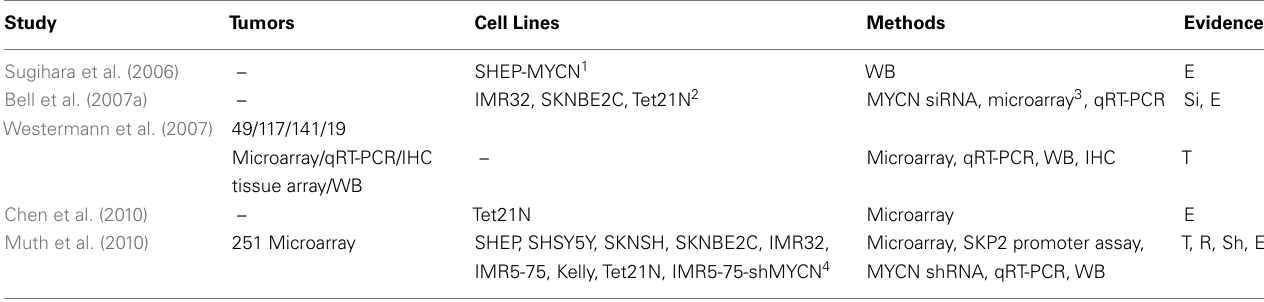
Table 2 | Summary of studies which have shown increased SKP2 expression in the presence of MYCN and/or MYCN amplification in